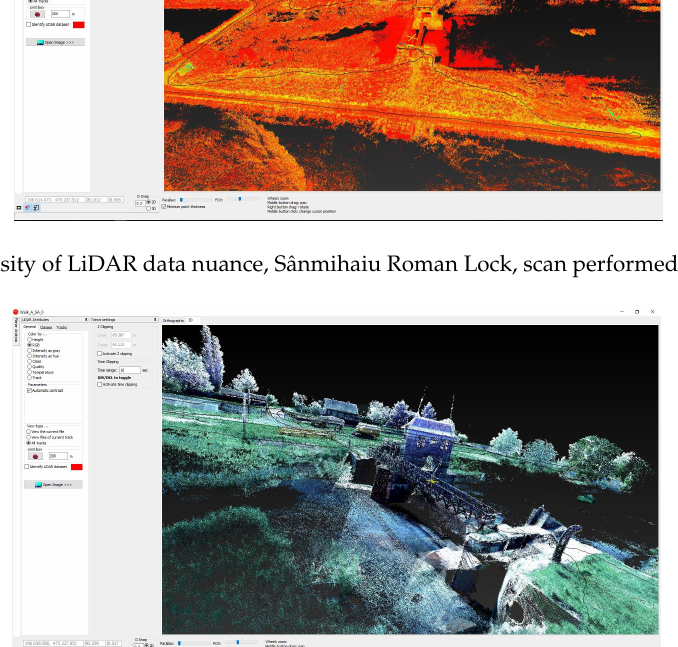
Figure 19. LiDAR data presentation, colored by altitude, NH Sânmihaiu Roman, construction site. Figure 20. Coloring of the points clouds by the Walks, NH Sânmihaiu Roman.